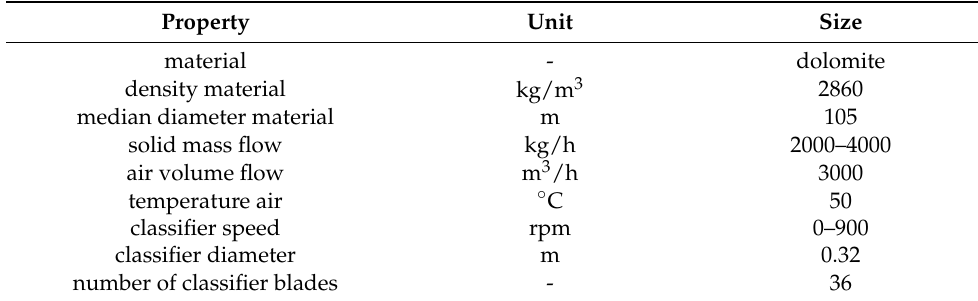
Table 1. Characteristic sizes of material, air, and classifier